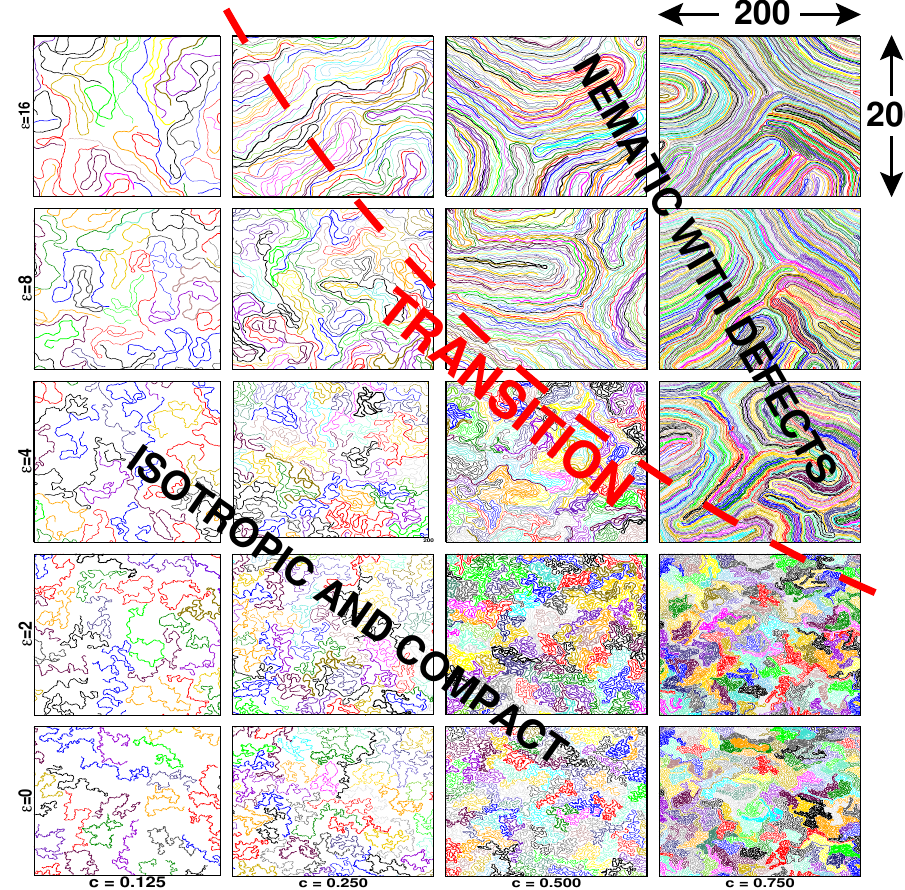
Figure 2. Snapshots of semiflexible 2D polymers of length N = 256 obtained by means of molecular dynamics simulation of a Kremer–Grest bead-spring model [56,79]. We show data for four concentrations c = NM / L 2 = 0.125 ( M = 192 chains, linear box size L ≈ 627), c = 0.250 ( M = 192, L ≈ 443), c = 0.500 ( M = 192, L ≈ 313) and c = 0.750 ( M = 384, L ≈ 362) and five bending penalties (cid:101) = 0, 2, 4, 8 and 16 (from the bottom to the top). Only small subvolumes of much larger boxes are represented. The configurations have been sampled by increasing (cid:101) starting with flexible and compact chain systems ( (cid:101) = 0) [68,76,80]. While the chains remain compact and segregated at low densities and stiffnesses below the dashed line, they are seen in the opposite limit to align (at least) locally, forming bundles of chains with hairpins, which are extremely difficult to